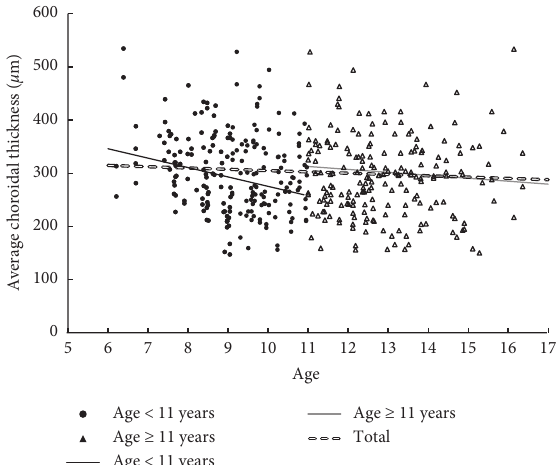
Figure 3: Scatterplot showing the correlation of subfoveal cho- roidal thickness versus age.